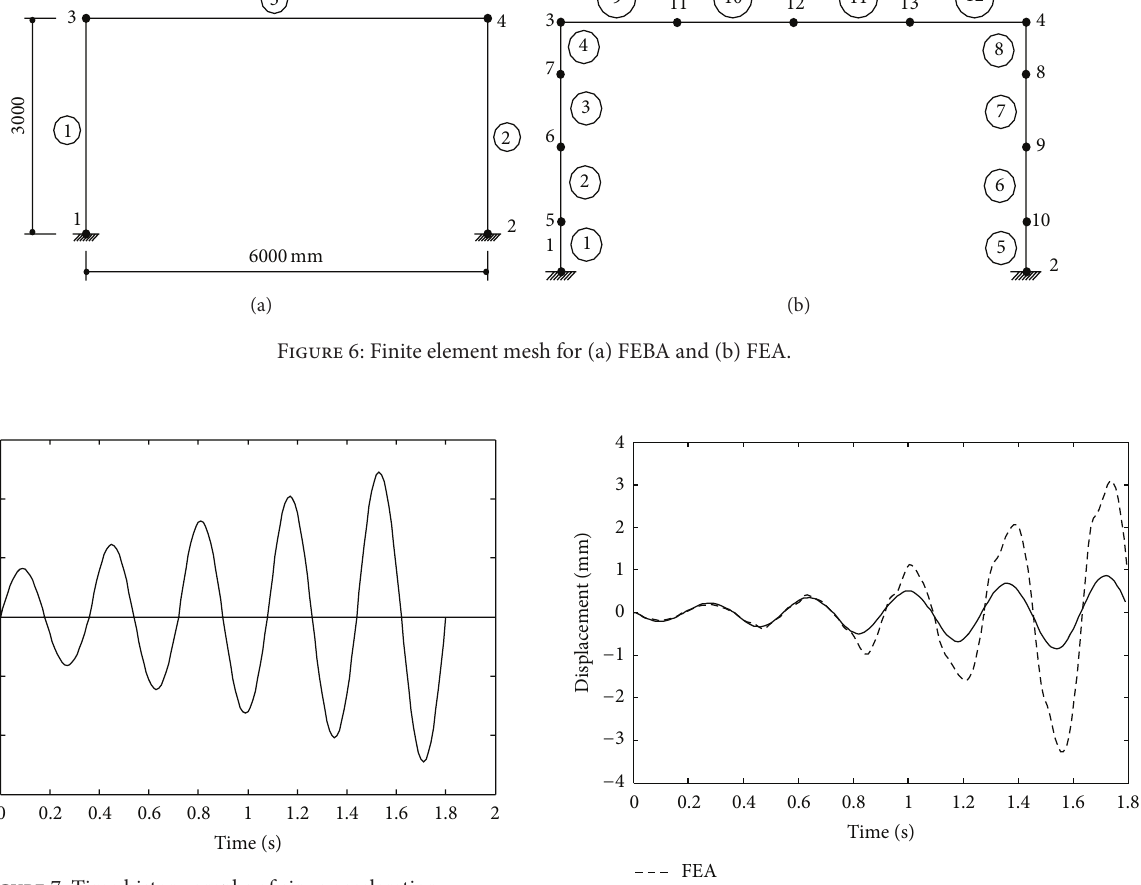
Figure 7: Time history graphs of sinus acceleration.